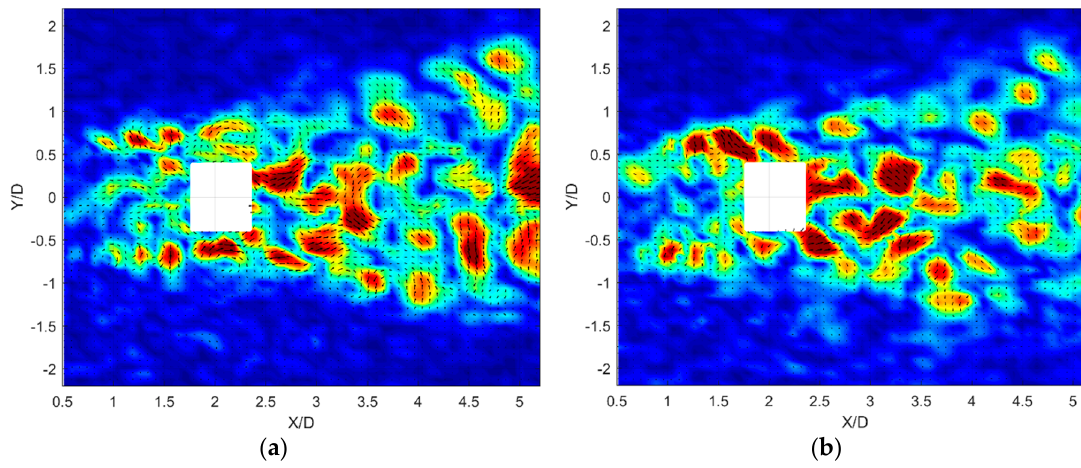
Figure 10. POD spatial modes for higher order: ( a ) S A = 30, ( b ) S B = 30. Color scale represents magnitude and is normalized to a common factor.